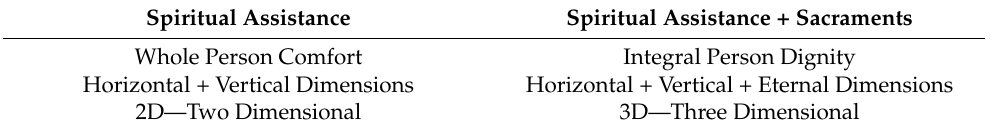
Table 1. Spiritual and integral